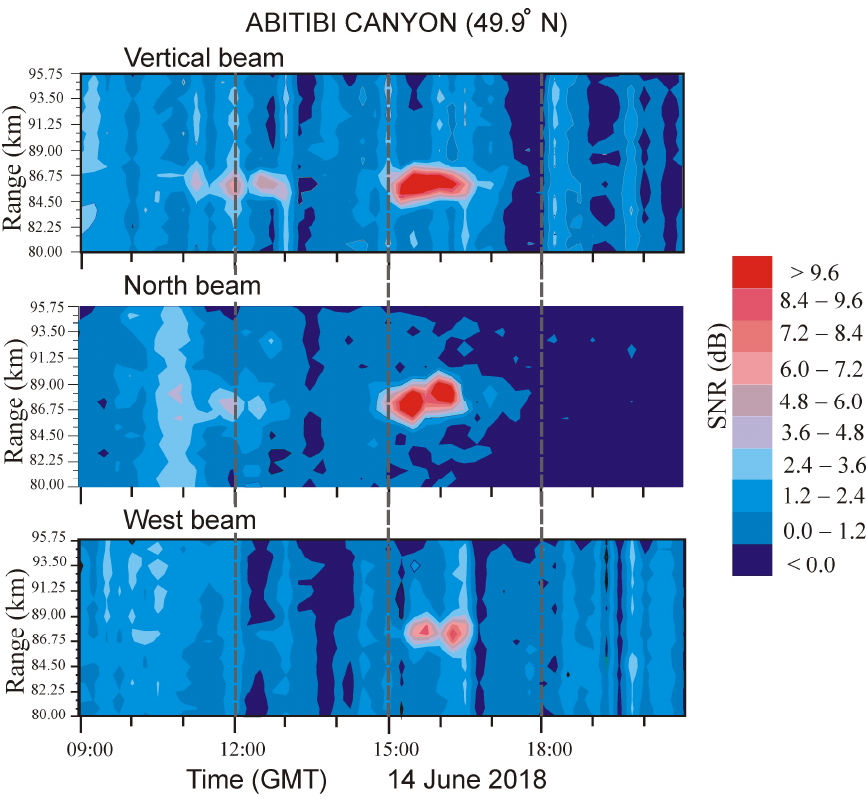
Figure 4. Contour plots of signals from ~80 to ~95 km altitude measured at Abitibi Canyon. In this case the signal-to-noise ratio (SNR) has been plotted.